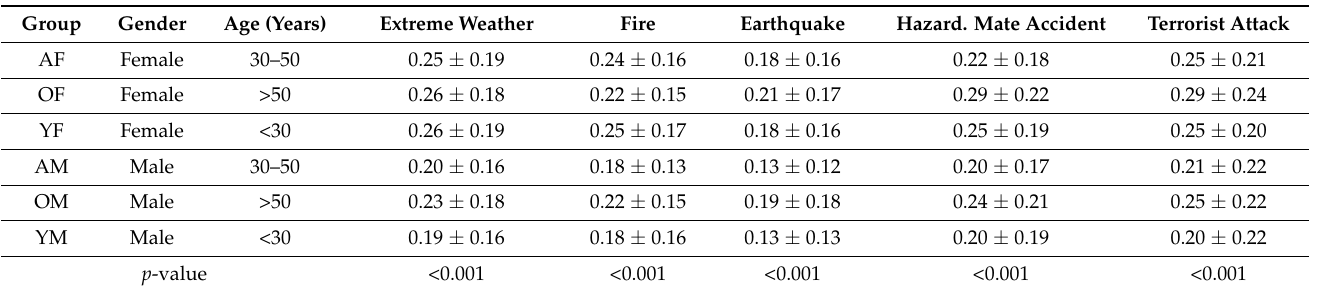
Table 8. Mean and standard deviation of risk scores [0, 1] by gender and age and p -values from the Kruskal-Wallis test ( α = 0.05).